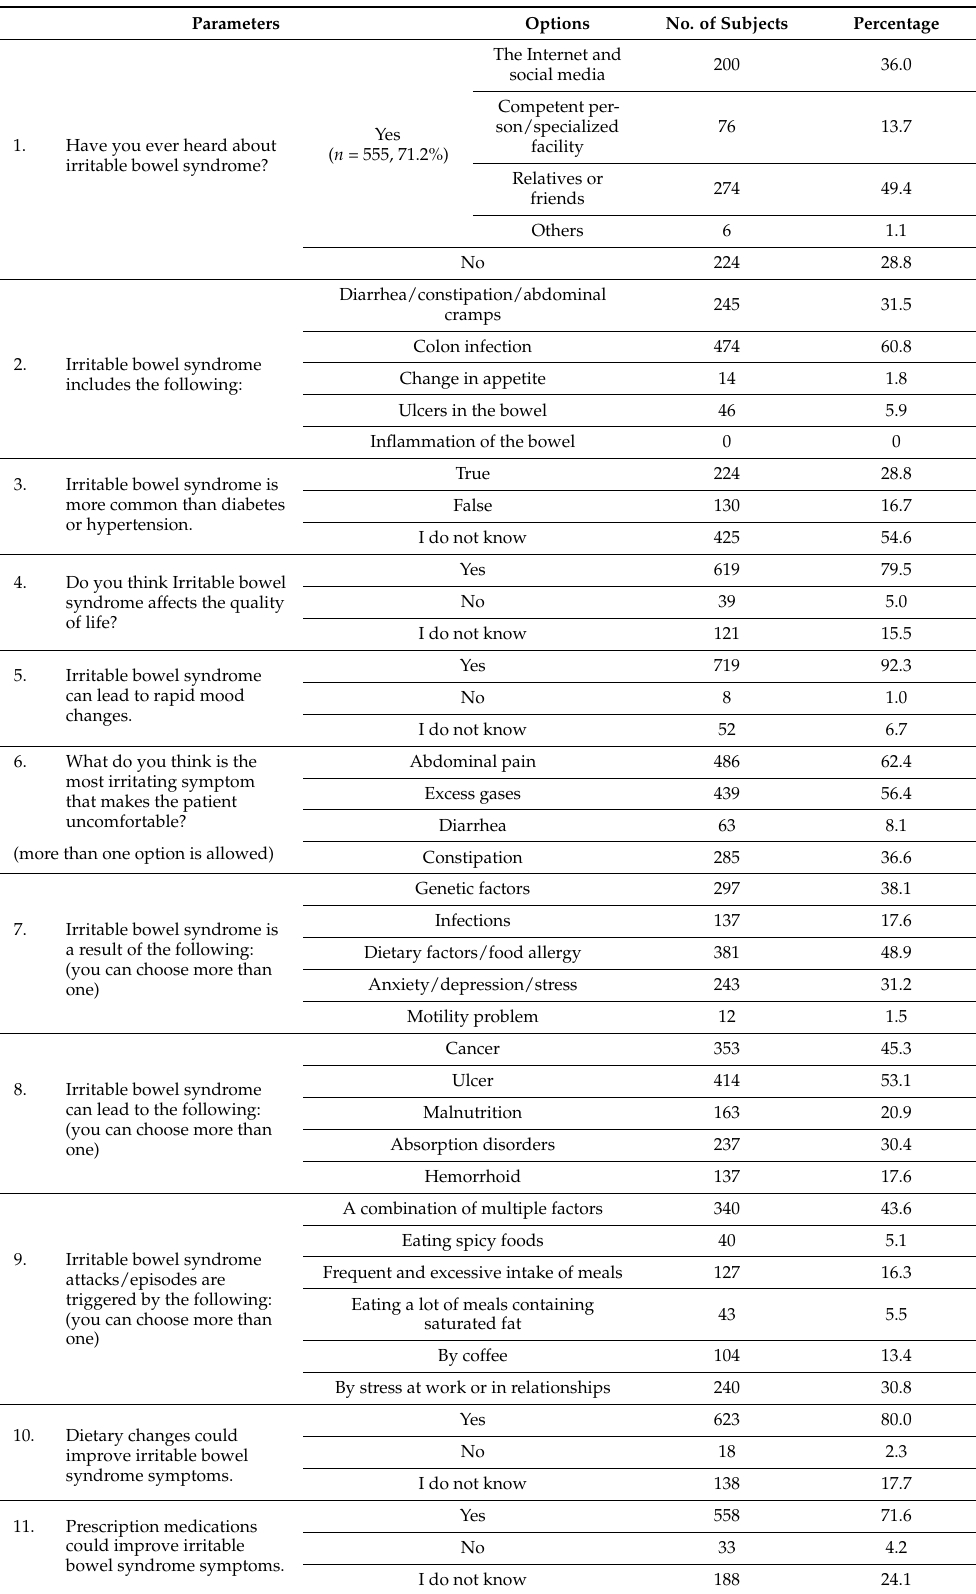
Table 2. Participants’ responses to knowledge items related to